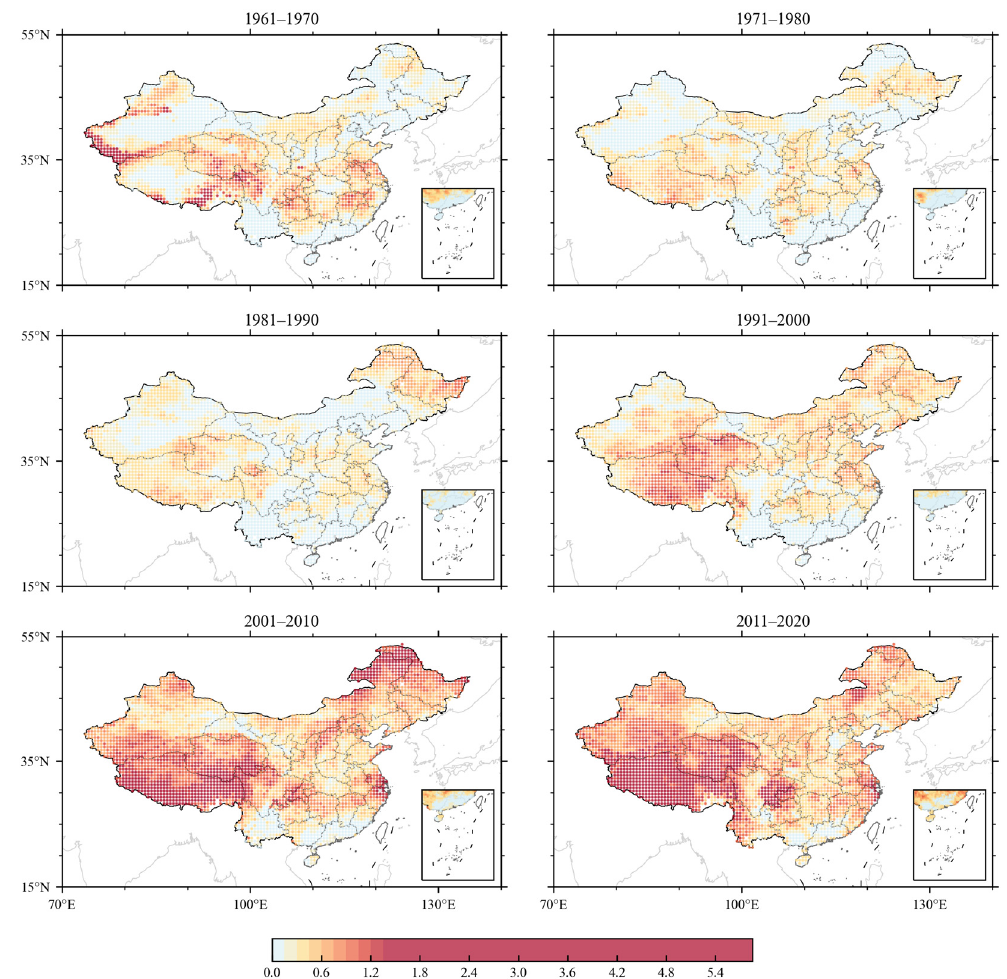
Figure 11. Distribution diagram of the decadal average frequency of heat waves based on VATM.